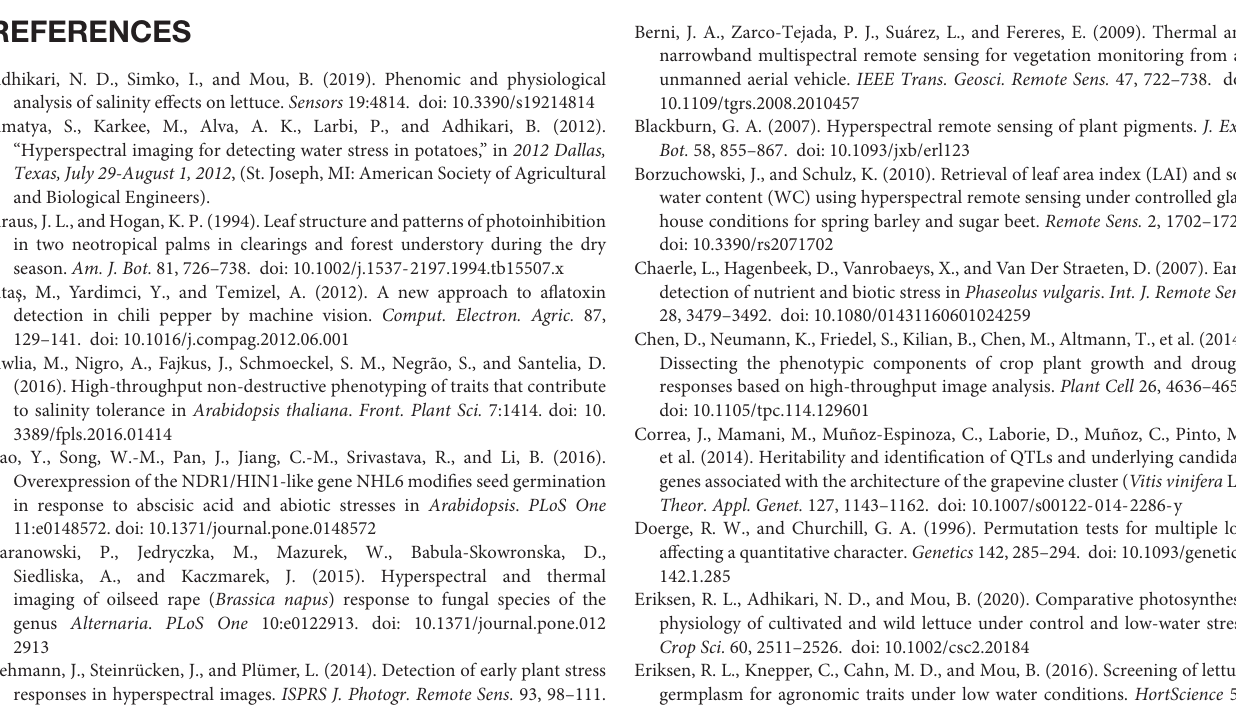
Supplementary Table 2 | Details of the QTL clusters and candidate genes identified in this